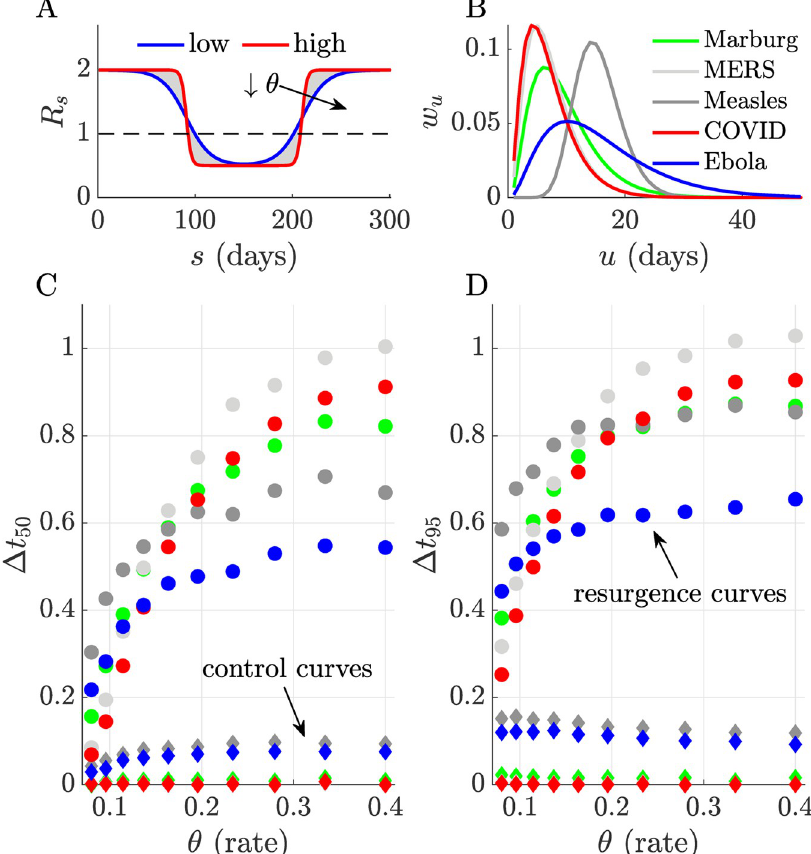
Fig 3. Delays in detecting upward and downward changes in R . We characterise the discrepancies between detecting resurgence and control against the steepness or rate, θ , of changes in transmissibility ( R s ), which we model using logistic functions (panel A, steepness increases from blue to red). We compare differences in the probability of detecting resurgence (P( R > 1)) or control (P( R � 1) under filtered and smoothed estimates (see main text) first s s crossing thresholds of 0.5 ( Δ t 50 ) and 0.95 ( Δ t 95 ) for five infectious diseases (panel B plots their assumed generation time distributions from [2,46,47]). We simulate 1000 epidemics from each disease using renewal models and estimate R s with EpiFilter [15]. Panels C and D (here colours match panel B, Δ t is normalised by the mean generation times of the diseases) show that delays in detecting resurgence (dots with colours indicating the disease) are at least 5–10 times longer than for detecting control (diamonds with equivalent colours). Our ability to infer even symmetrical transmissibility changes is fundamentally asymmetric, largely due to the differences in case incidence at which those changes usually tend to occur.